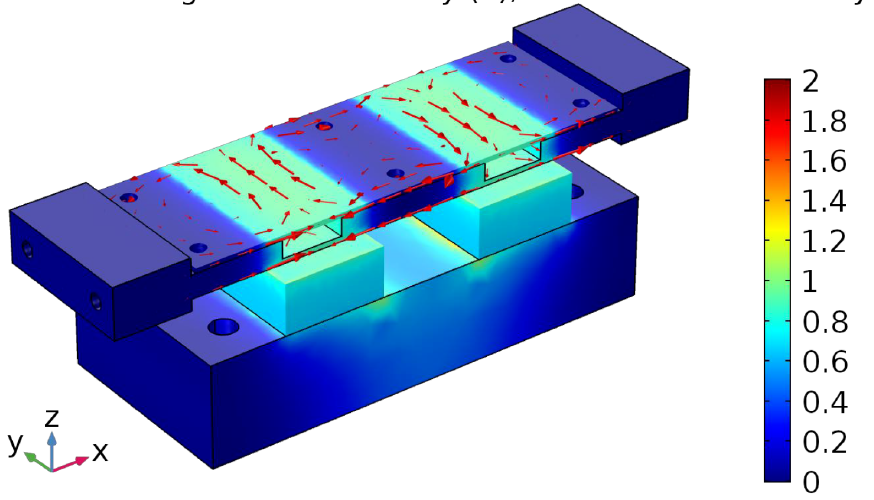
Figure 13. Simulation showing the magnetic flux density (in T on the colorbar) and the eddy current density (arrows)